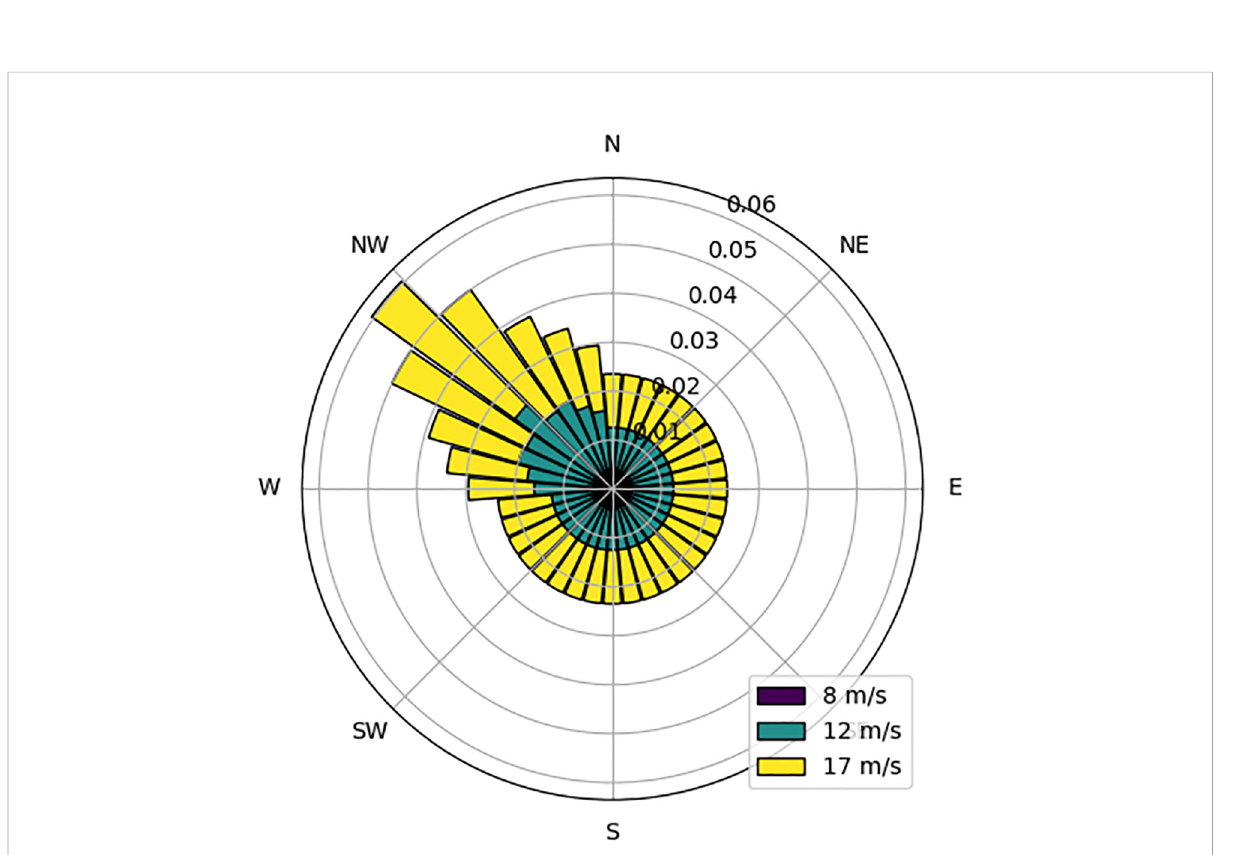
FIGURE 8 Wind rose for Case 3.